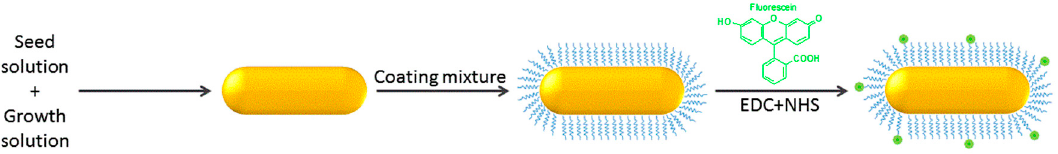
Figure 10. A schematic representation of the GNRs’ fabrication and fluorescein conjugation process.